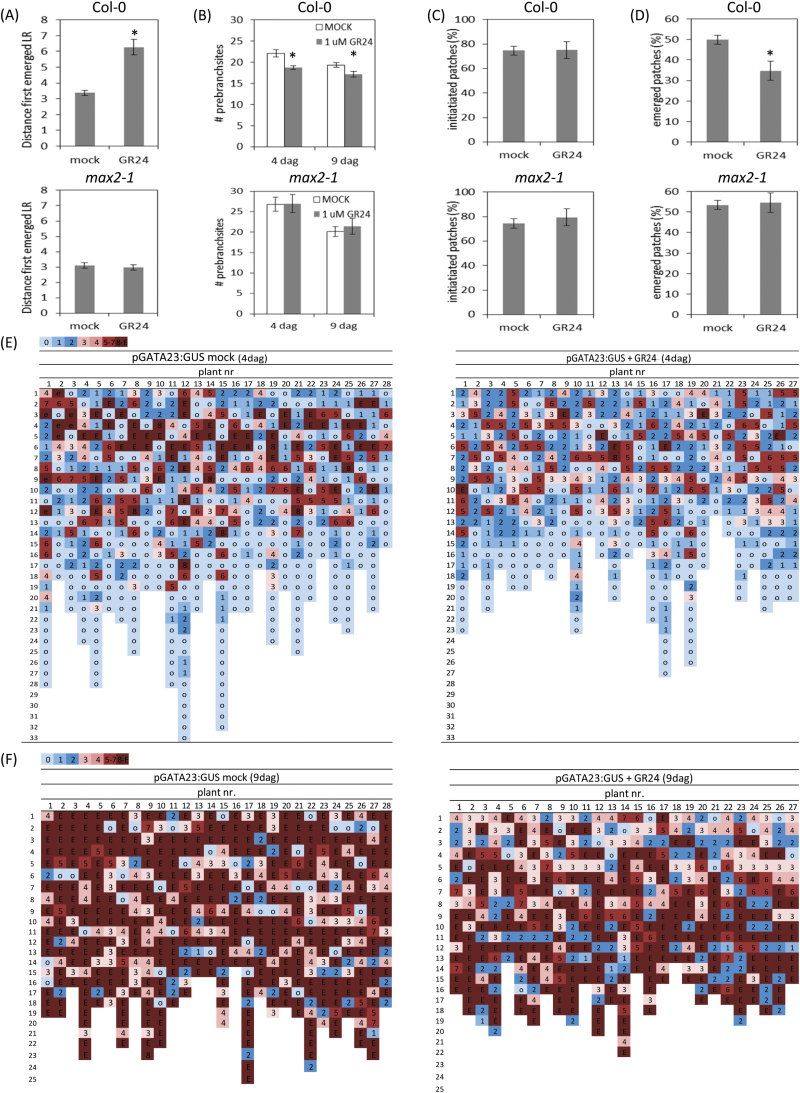
Effect of exogenous GR24 on LR development near the root–shoot junction.(A) Distance to the first emerged LR in Col-0 (top) and max2-1 (bottom). (B) Total number of prebranch sites under mock (white bars) and GR24 treatment (gray bars), 4 and 9 DAG in Col-0 (top) and max2-1 (bottom). (C) Percentage of initiated patches under mock and 1 μM GR24 treatments in Col-0 (top) and max2-1 (bottom) at 9 DAG. (D) Percentage of emerged patches under mock and GR24 treatment in Col-0 (top) and max2-1 (bottom). (A–D) Data presented are means ± standard error (SE) of three biological repeats (n>20). *P<0.001, according to the Student’s t-test. (E, F) Stages of LR primordia via GATA23:GUS staining in Col-0 under mock (left) and GR24 treatment (right) at 4 DAG (E) and 9 DAG (F). All events, possibly leading to emerged LRs, were scored in individual plants, color-coded, and for each plant, vertically ordered from the closest to the hypocotyl (up) downward to the meristem (down). The root fragments used for analysis were comparable in length. Data of one representative experiment are shown. The experiments were repeated three times with similar results.